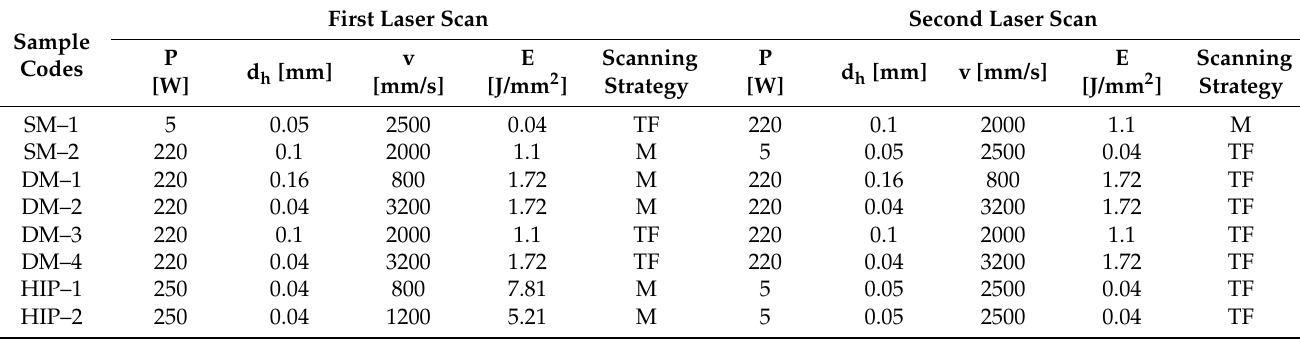
Table 2. Parameters used for the different scan strategies in single melted (SM), double melted (DM), and samples with a further post–processing HIP. Codes: P , laser power; d h , hatch distance; v, scanning speed; E , energy per surface area; TF , total fill; M,